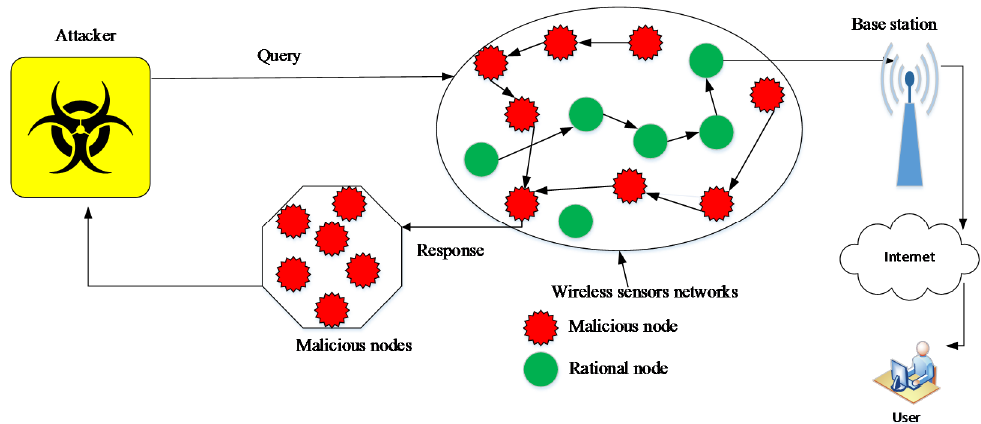
Figure 1. The architecture of rational nodes without choosing defense.